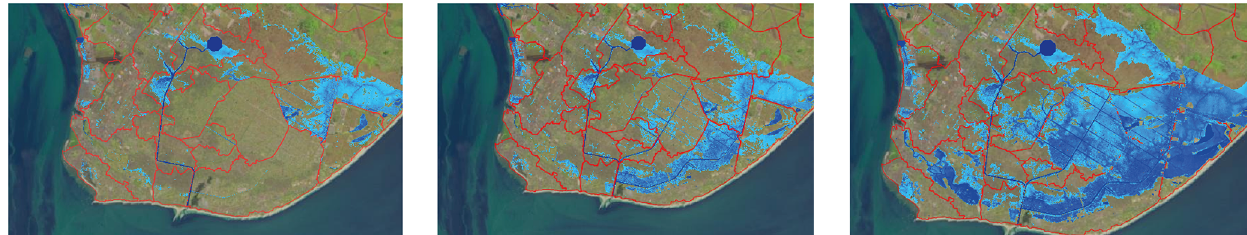
Figure 6. Flood map for a 2-year rainfall event (left), 10-year rainfall event (middle), and a 10-year rainfall event plus a 10-year coastal surge event (right). Background image: Sentinel-2 (© ESA).